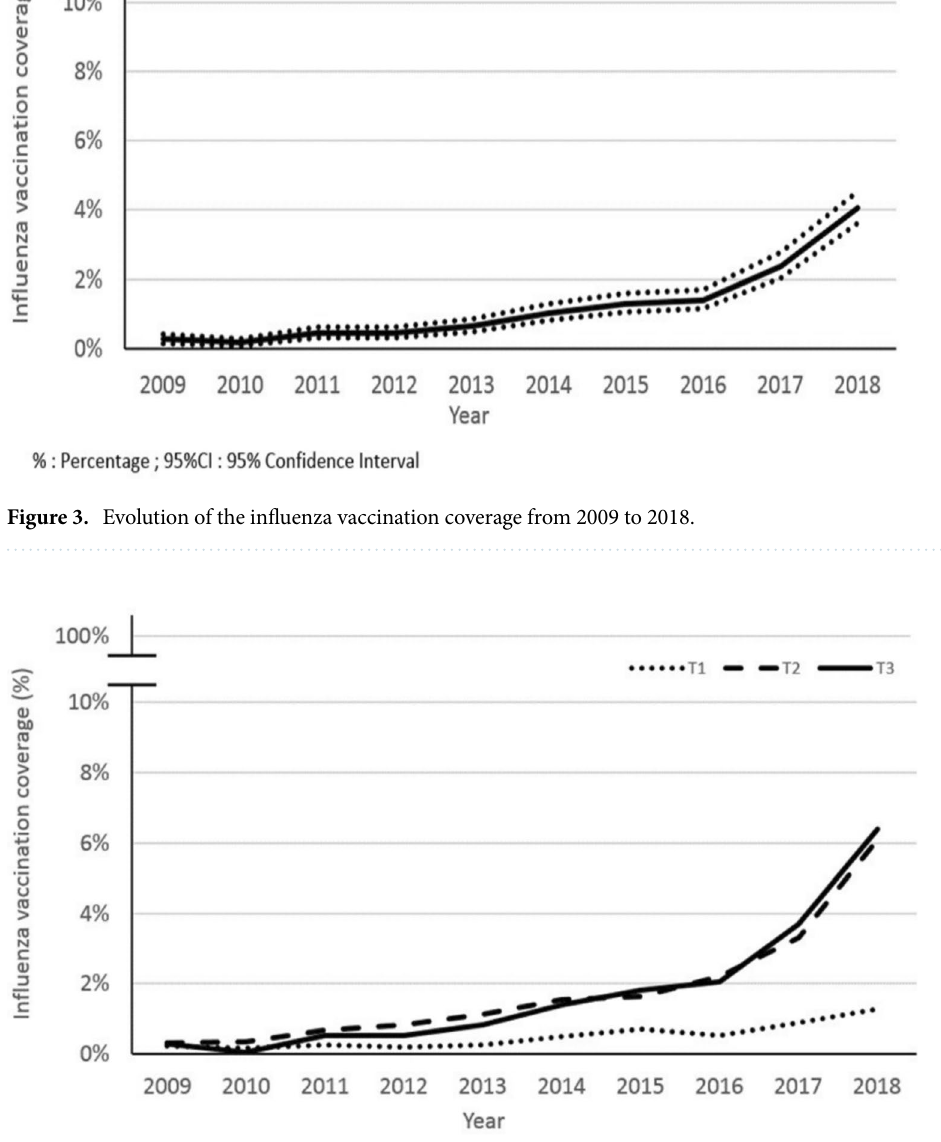
Figure 4. Evolution of influenza vaccination coverage by trimester of pregnancy during the vaccination